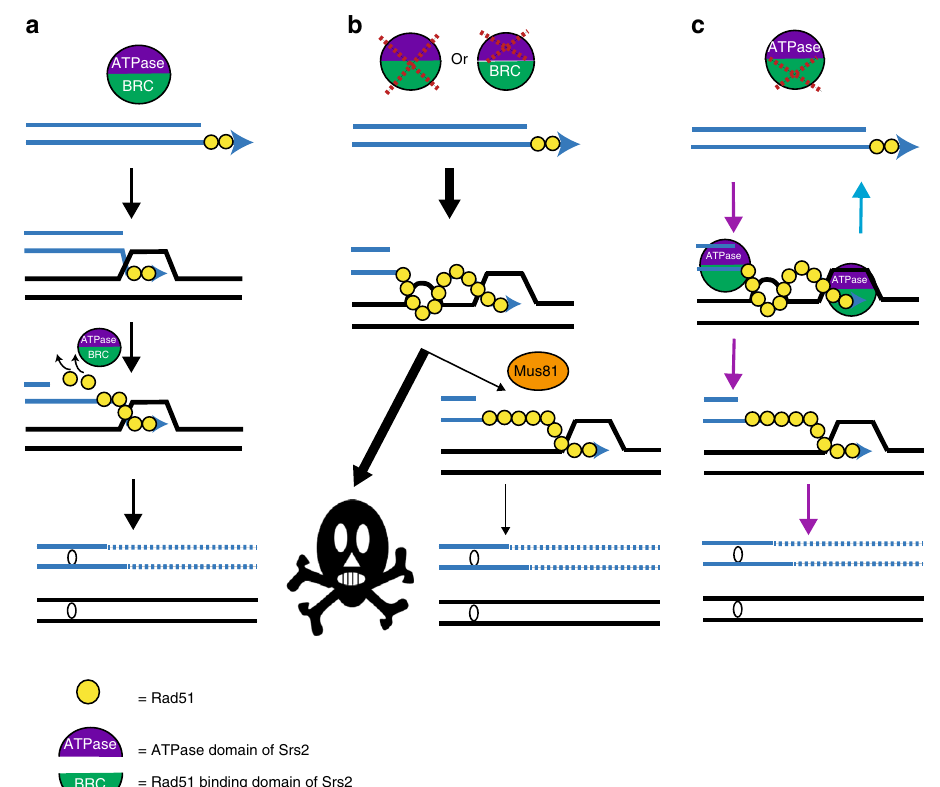
Fig. 6 The model of BIR associated toxic joint molecules. a The strippase activity of Srs2 requiring both the ATPase domain (purple semi-circle) and the Rad51 binding domain (BRC; green) removes excess of Rad51 (yellow circles) from the fi lament, which prevents formation of toxic intermediates behind the migrating BIR bubble, and ensures ef fi cient BIR. b In the absence of Srs2 or of its ATPase activity ( srs2-K41A ) additional Rad51 bound to long ssDNA leads to formation of toxic intermediates, which predominantly lead to cell death (denoted by the skull), but can be resolved by Mus81-Mms4, which allows BIR completion and cell survival. c When strippase activity of Srs2 is defective (in the absence of the Rad51 binding domain), toxic intermediates are accumulated, but can be dismantled by helicase activity of Srs2 (pink arrow). In addition, Srs2 can unwind D-loops using its helicase activity (blue